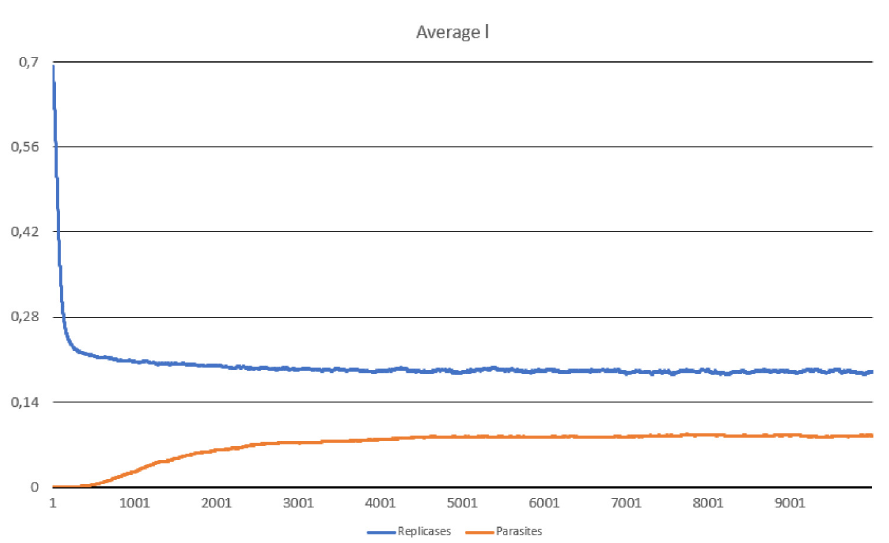
Fig 4. The average probability of being in the folded state, computed for parasites and replicases in Scenario 1.